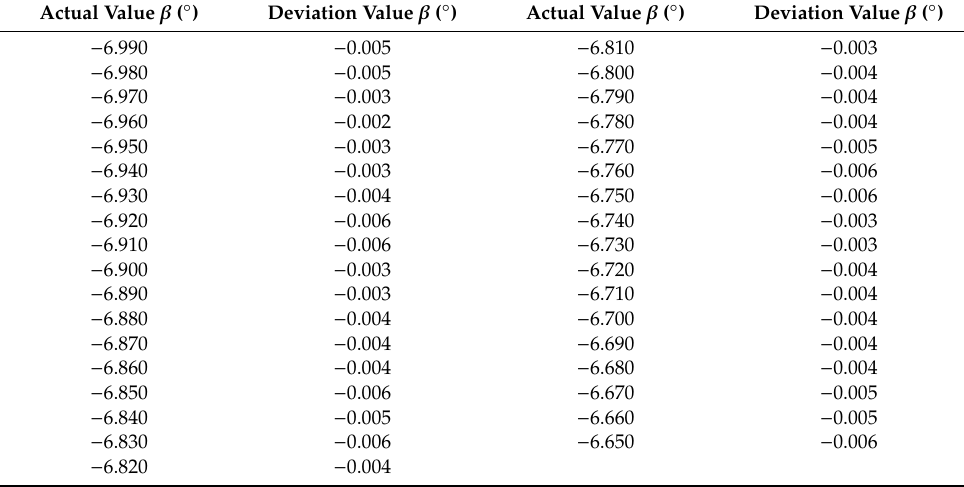
Table 1. α changes with each 0.01 ◦ , the detection output value of ball